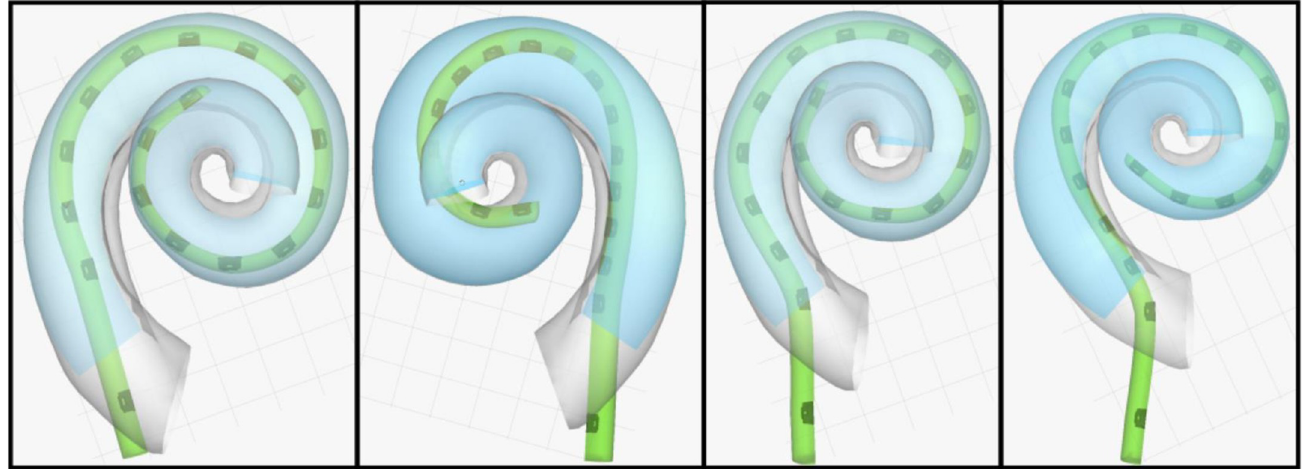
Fig 3. Top view from left to right. ID 24 (Scala tympani without touching the basilar membrane, relatively deep insertion in a small cochlea); ID 27 (translocation of MidScala array); ID 28 (soft contact with the basilar membrane and some slight buckling in the middle part of the array); ID 35 (good position, little less than full